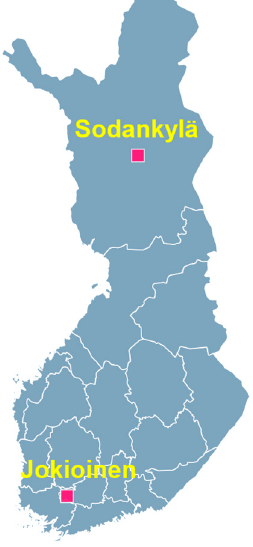
Figure 1. The locations of the stations in Finland.